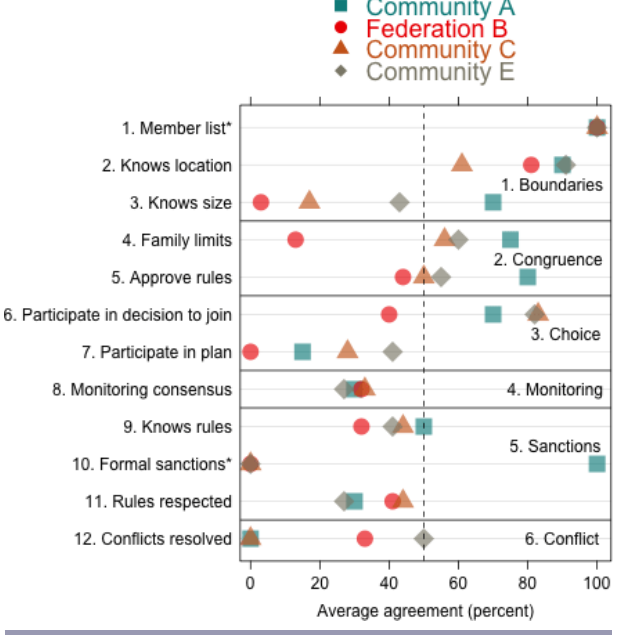
Fig. 2 . Visual representation of responses from structured interviews in the four communities as measures for each of the first six of Ostrom’s (1990) institutional design principles. Principle 1 represents the constitutional level; principle 3 represents the collective-choice level; and principles 2, 4, 5, and 6 represent the operational level. Measures (left) for each principle (right) are listed in Table 2, representing percent agreement with the measure within each community. Measures between 50% and 100% agreement (to the right of the vertical dashed line) indicate stronger institutional performance, and measures between 49% and 0% (to the left of the vertical dashed line) indicate weaker institutional